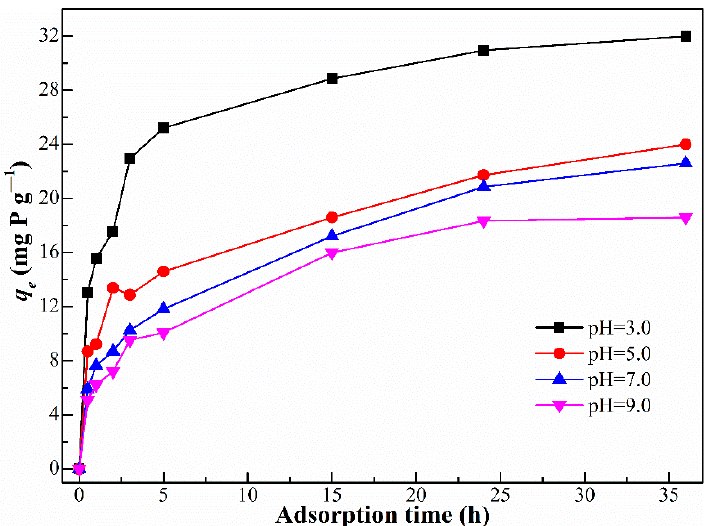
Figure 10. Effect of pH on the adsorption capacity of the La-chitosan magnetic spheres.